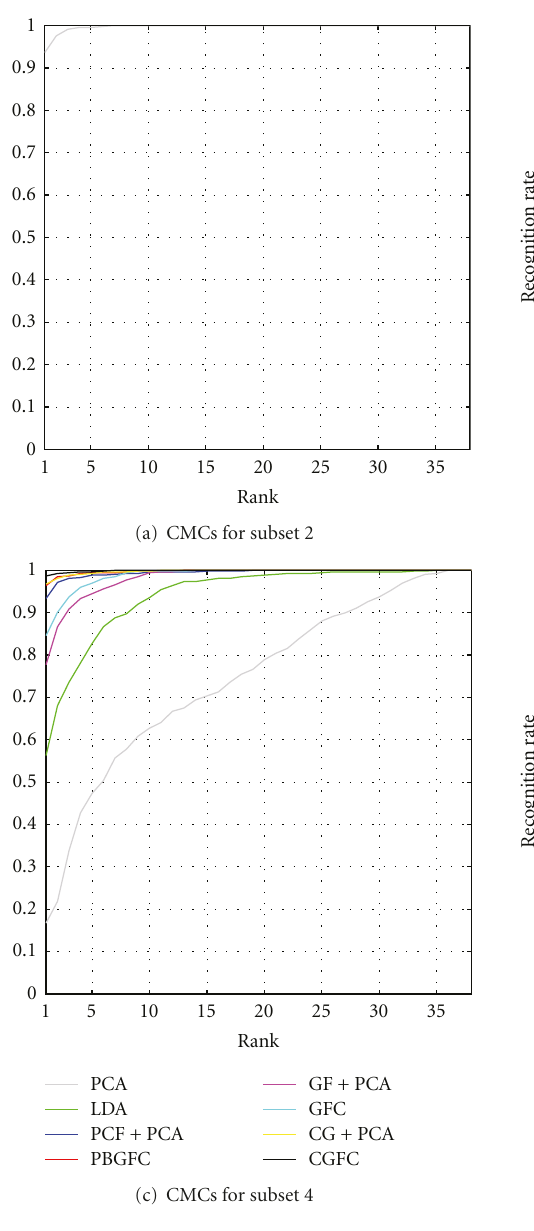
Figure 23: CMC curves obtained on the four probe subsets of the EYB